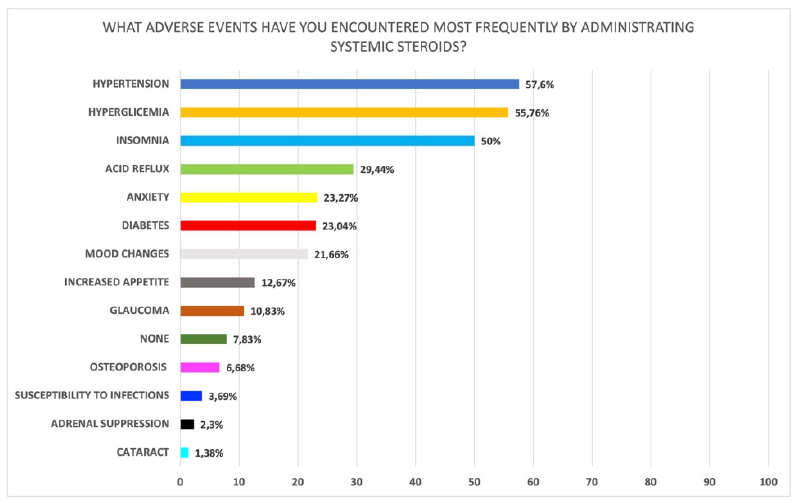
Figure 3. Adverse events most frequently observed with oral corticosteroids (Q26 of Supplementary Materials File). Materials